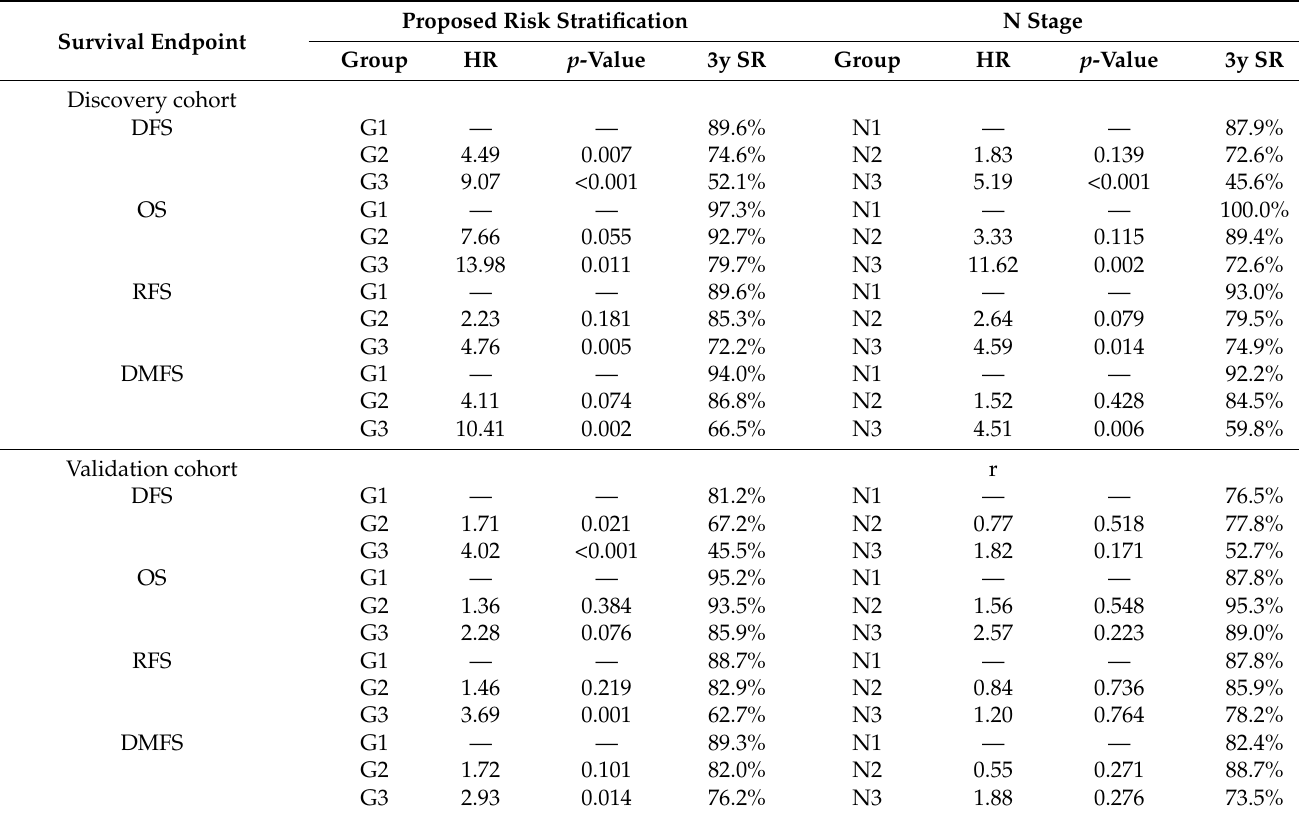
Table 4. Risk stratification performance of the proposed risk groups and N stage in multiple survival endpoints and discovery and validation